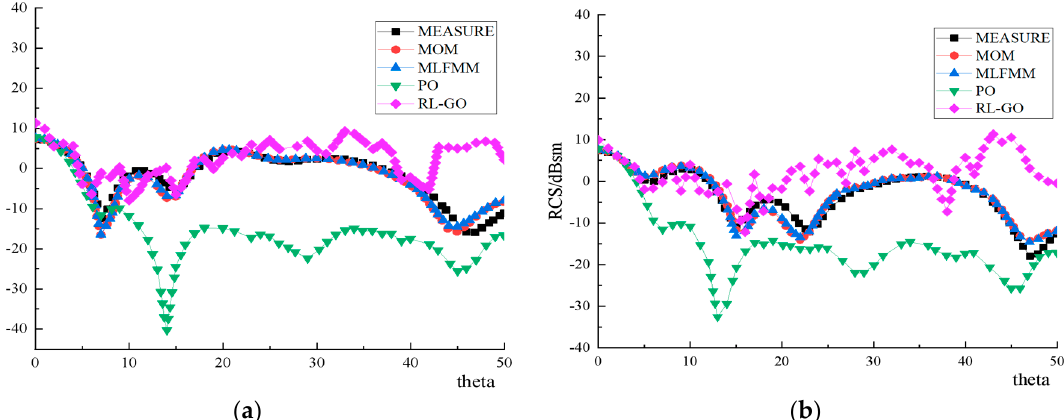
Figure 5. Results of RCS calculation and experiment. ( a ) Horizontal polarization ( b ) Vertical polarization.